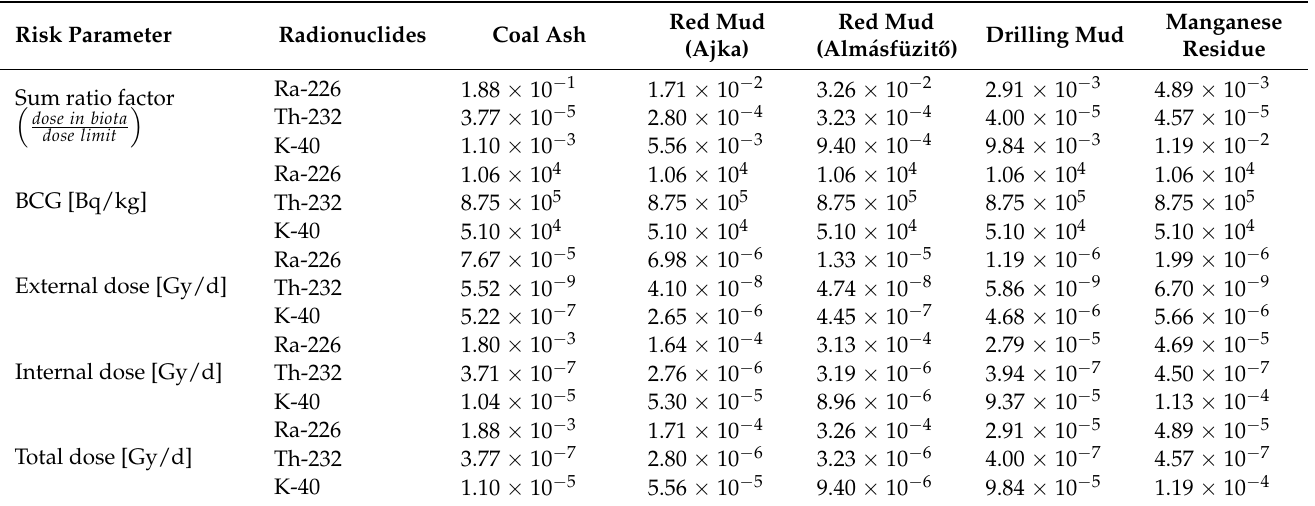
Table 4. The sum ratio factor, biota concentration guide (BCG), external dose, internal dose, and total dose of the investigated radionuclide in terrestrial plant by soil